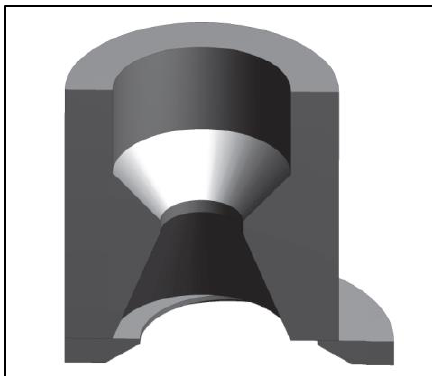
Figure 24. 3D model of a nozzle with a movable diaphragm (view with a radial diaphragm displacement is shown). Nozzle dimensions: D11 = 8 mm; D1 = 6 mm; D2 = 8.34 mm; D22 = 13 mm; γ1 = 45 degrees; γ2 = 7 degrees. A series of calculations were performed to assess the technical capabilities of the known nozzle equipped with a diaphragm. As an example, the conditions of air outflow through the nozzle with the inlet pressure of 1.0 MPa (temperature of 40 °С) at ambient pressure of 0.1 MPa (temperature of 20 °С) are considered. When the nozzle and the diaphragm are arranged concentrically, as shown in Figure 25, the jet at the nozzle outlet extends along the longitudinal nozzle axis. Calculation parameters: total number of cells in the computational grid = 1153165; computation time = 29298 s; the number of iterations = 1499.